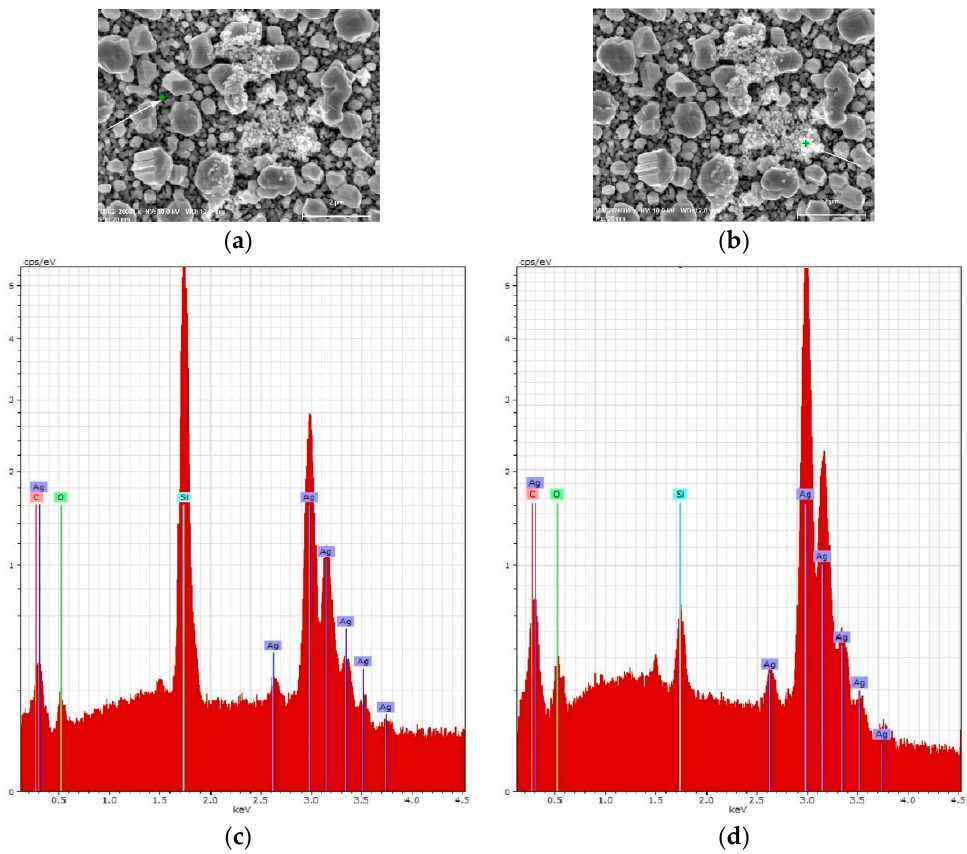
Figure 8. ( a , b ) SEM top view images of the silvered por -Si after adsorption of the lactoferrin molecules; ( c , d ) EDX spectra corresponded to the spots marked with a green cross on the SEM images.